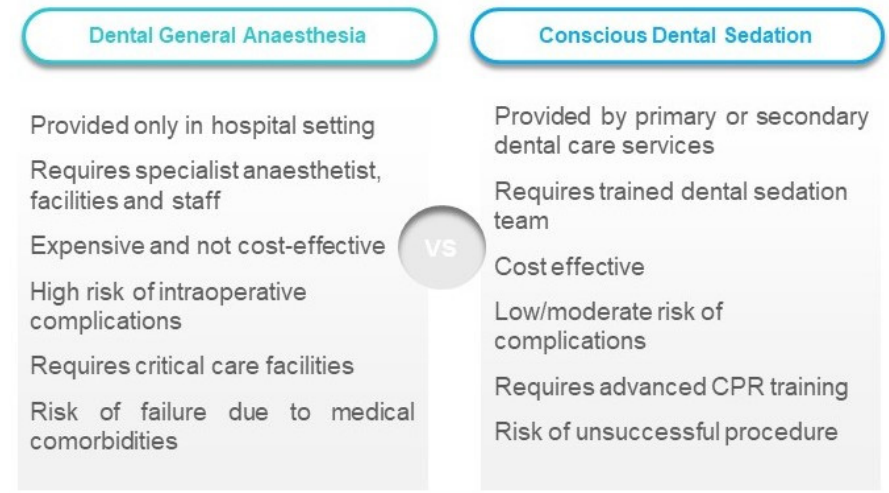
Figure 2. Comparison of general anaesthesia provision in dental care vs. dental conscious sedation.